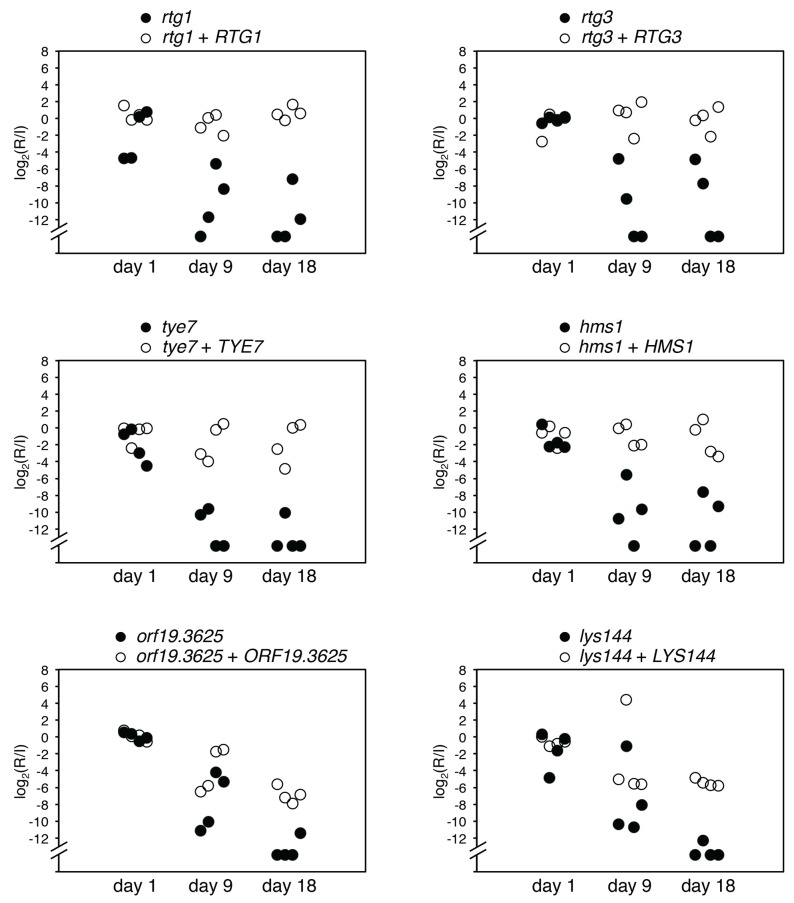
Wild-type genes restore ability to endure in the intestine to mutants impaired in colonization.Two-strain oral infections were carried out comparing each mutant to a gene add-back strain in four mice. qPCR was used to estimate the abundance of each strain. Shown are the log2 (recovered/inoculum) values per mouse for the mutant (closed circles) and the add-back (open circles) strains.